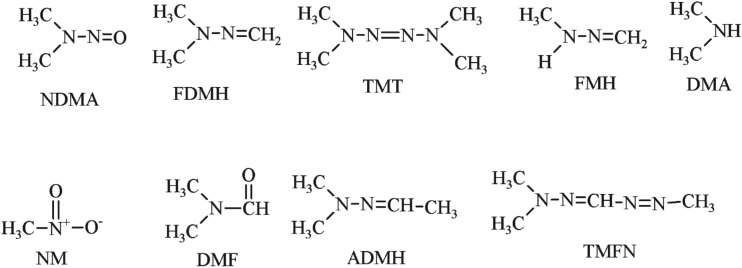
The structural formula of the products in table 1.